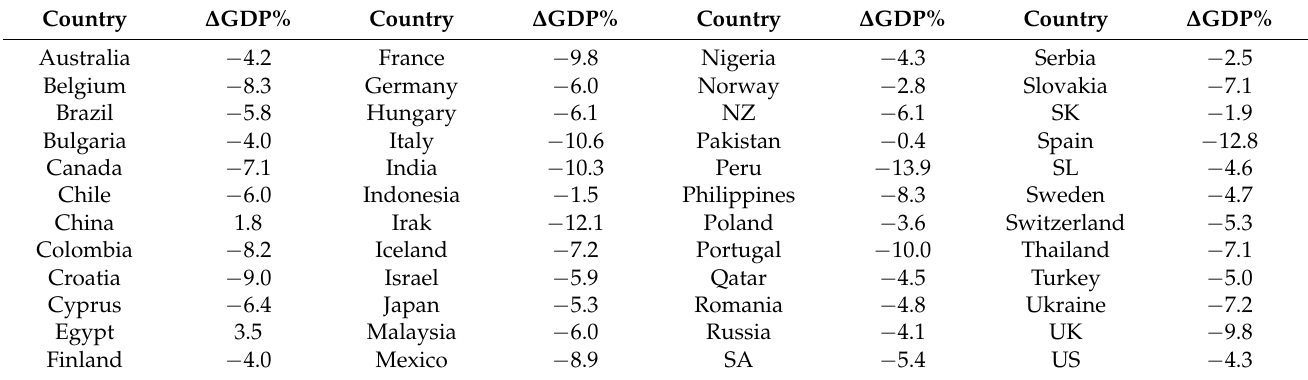
Table 2. ∆ GDP% of the indicated country in 2020 (Source: International Monetary